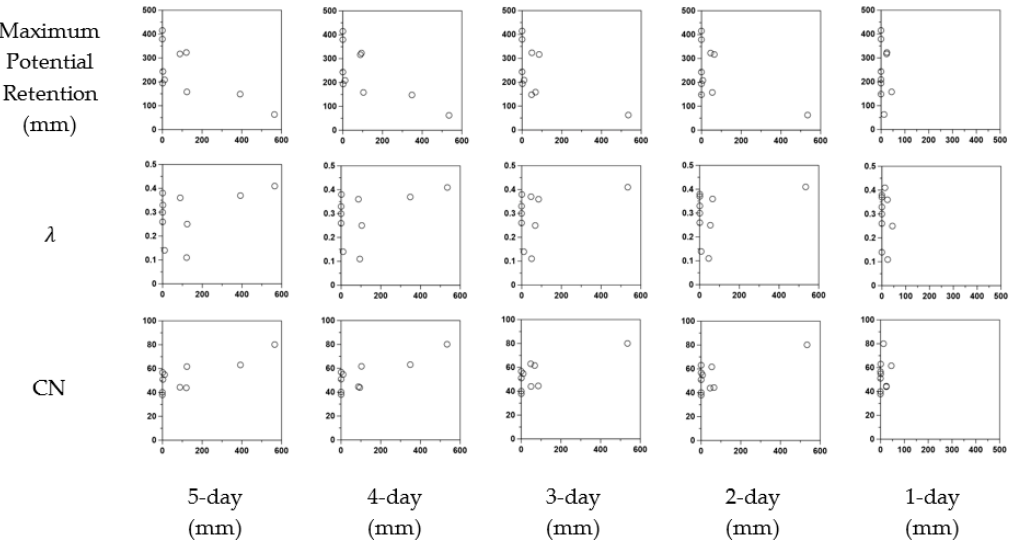
Figure 8. Change of maximum potential retention, λ , and CN depending on the antecedent n-day rainfall amount.